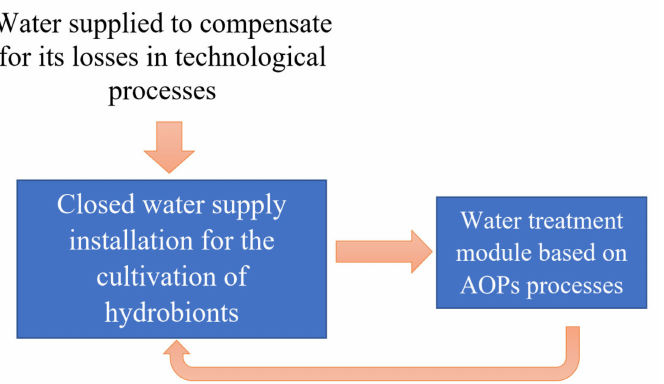
Figure 3. Scheme of connection of the AOP module to a closed-loop water supply system for the cultivation of